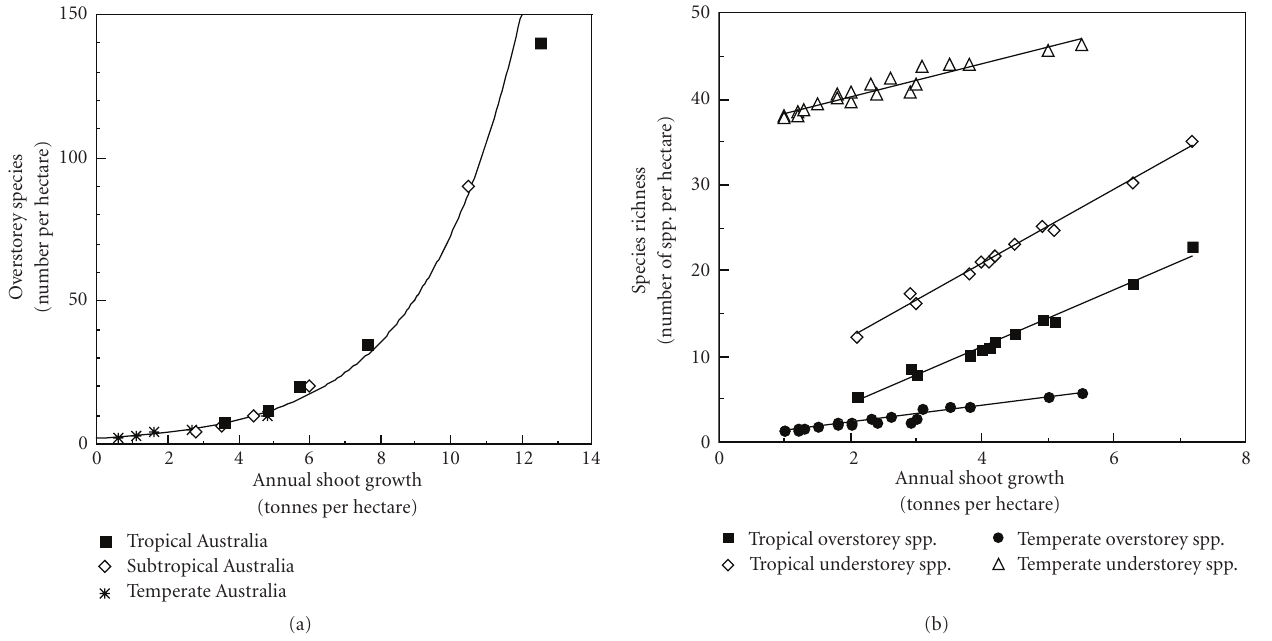
Figure 4: (a) The relationship between species richness ( N , number of species per hectare) of overstorey species in major plant communities—growing on soils of medium nutrient status—with Annual Shoot Growth (biomass per hectare) in tropical, subtropical and temperate eastern Australia (after [14, 15]). Overstorey N = 1 . 95 ∗ 10 0 . 157ASG ( n = 15; r 2 = 0 . 98). (b) The relationship between species richness ( N , number of species per hectare) of overstorey and understorey species in major plant communities— growing on nutrient-rich to nutrient-poor soils—with Annual Shoot Growth (ASG, biomass per hectare) in tropical and temperate Australia (Table 1). Temperate overstorey N = 0.99 ASG + 0.35 ( n = 20; r 2 = 0 . 94). Temperate understorey N = 1.93 ASG + 36.5 ( n = 20; r 2 = 0 . 93). Tropical overstorey N = 3.33 ASG − 2.13 ( n = 13; r 2 = 0 . 98). Tropical understorey N = 4.30 ASG + 3.61 ( n = 13; r 2 = 0 .